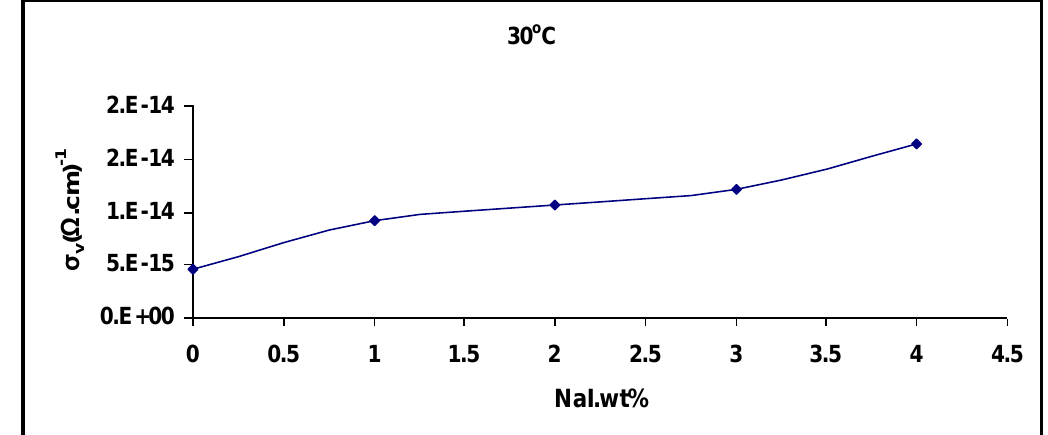
Fig.5:The electrical volume conductivity σ (Ω.cm) -1 as a function of the wt% of sodium v iodide NaI at a temperature 30 o C